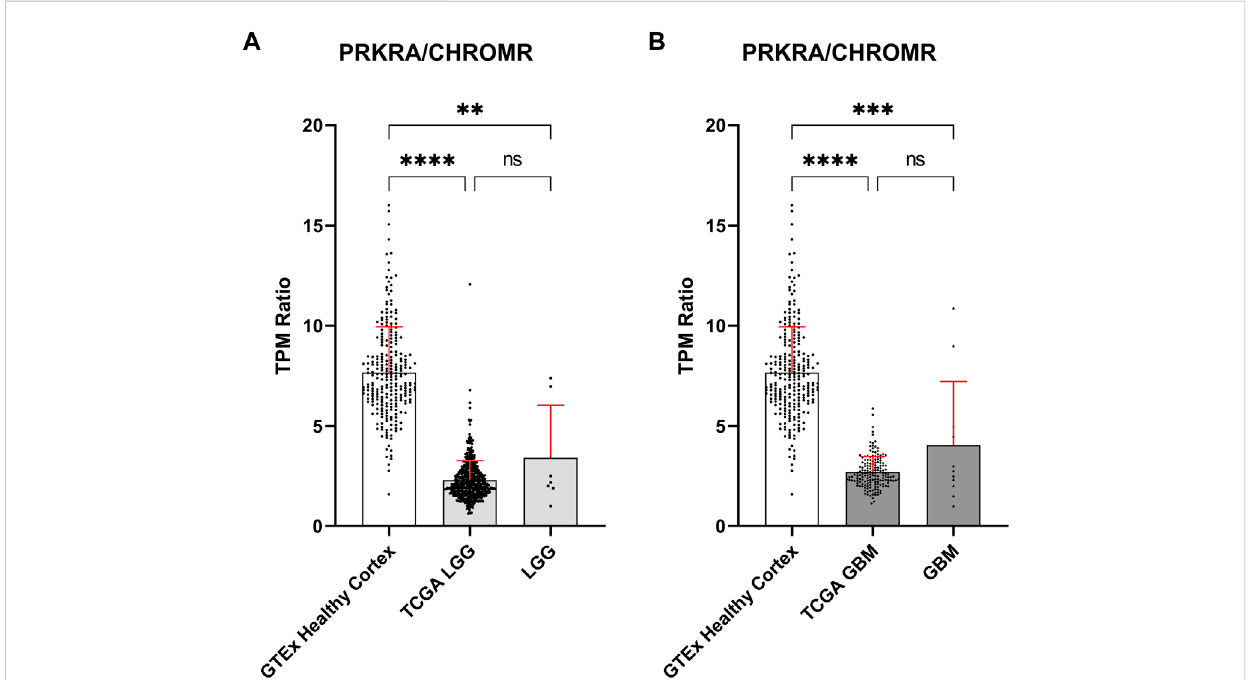
FIGURE 2 Comparison of mRNA PRKRA/lncRNA CHROMR gene expression ratio in LGG and GBM. (A,B) Comparing mRNA PRKRA/lncRNA CHROMR expression ratio of GTEx database Healthy Cortex samples with LGG (A) and GBM samples (B) . N (GTEx Healthy Cortex, TCGA LGG, TCGA GBM) = 255; 532; 168; respectively. LGG and GBM here denotes our in-house RNA-seq data. Data is represented as mean with standard deviation. Kruskal-Walli ’ s test with Dunn ’ s multiple comparison test. ns — p > 0.05; ** - p < 0.01; *** - p < 0.001, **** - p <